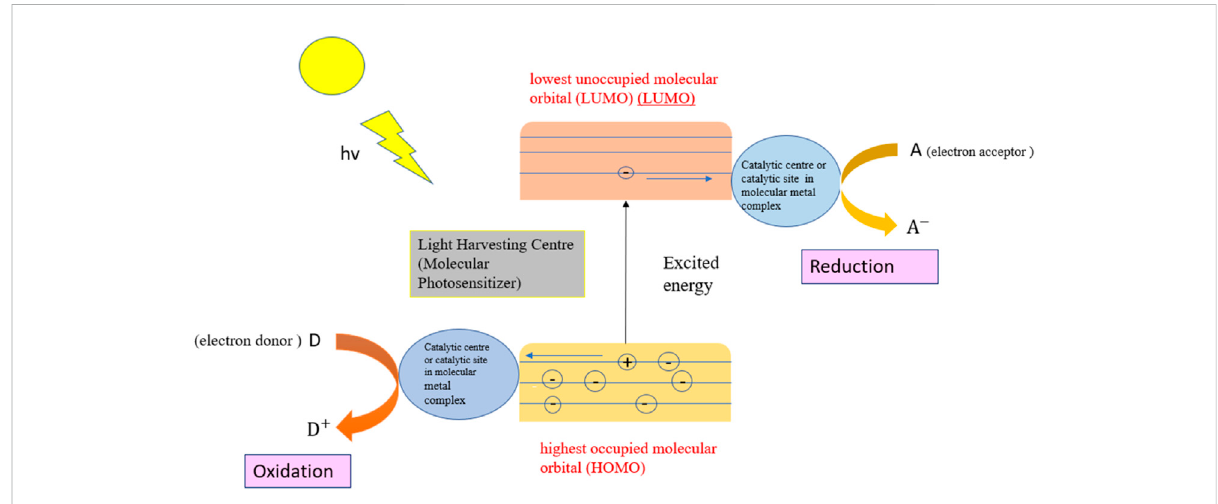
FIGURE 7 Photocatalytic process in a typical homogenous photocatalytic system.